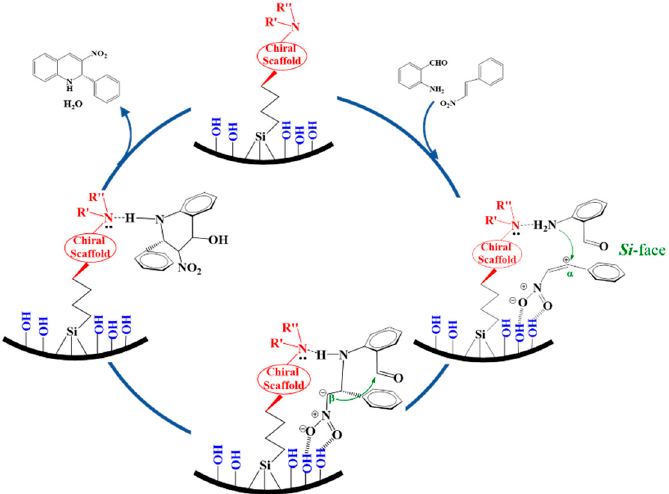
Figure 3. The proposed heterogeneous catalytic mechanism for SBA-15 immobilizing tertiary amine in the aza-Michael–Henry cascade